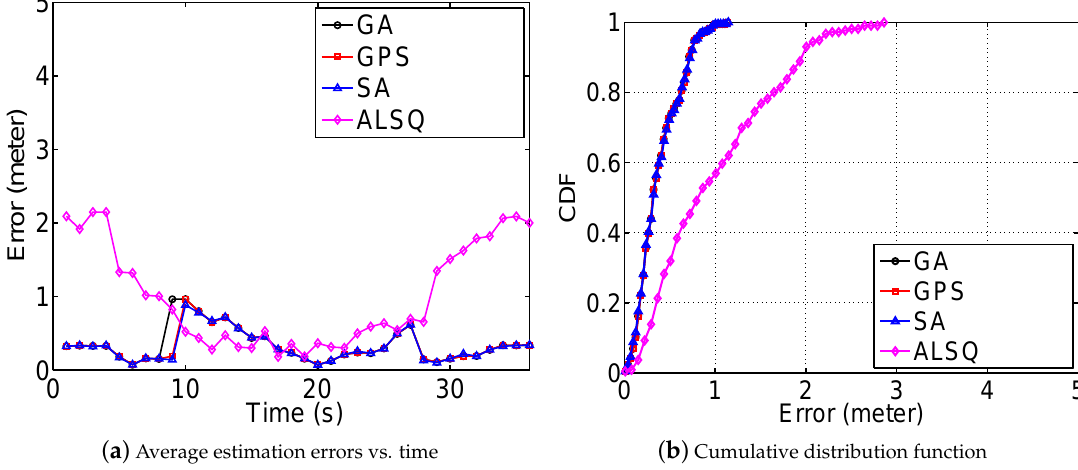
Figure 7. Performance of the far-field chasing algorithm. GPS, generalized pattern